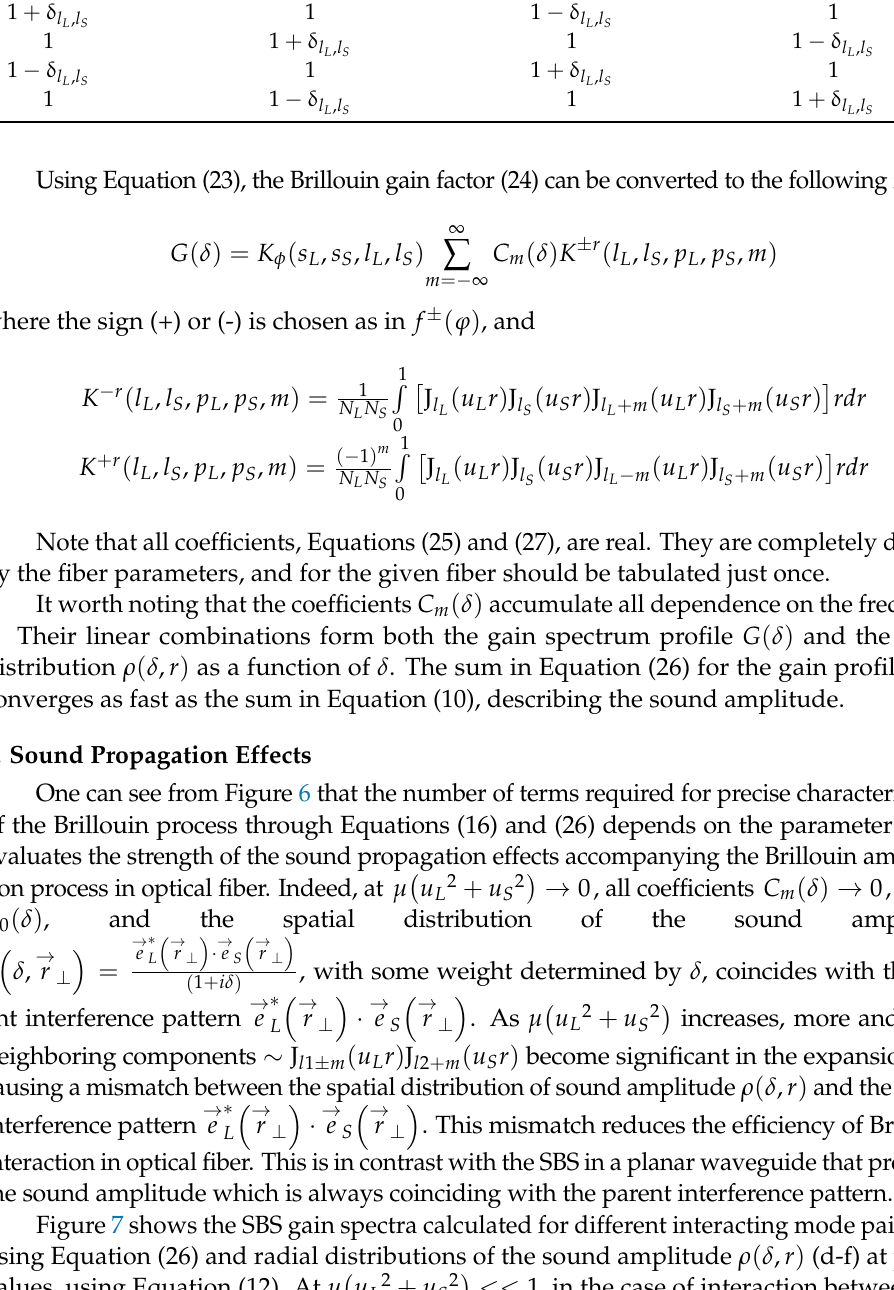
Table 2. The coefficient 4 K φ ( s L , s S , l L , l S ) for different types of interacting modes. Pump \